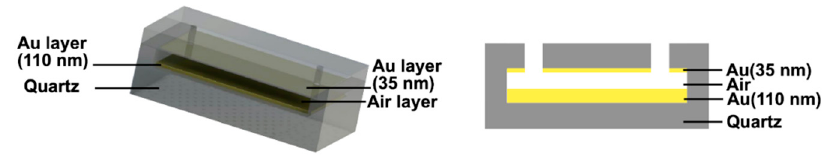
Figure 3. Symmetrical metal-cladding plasmonic waveguide dimensions.